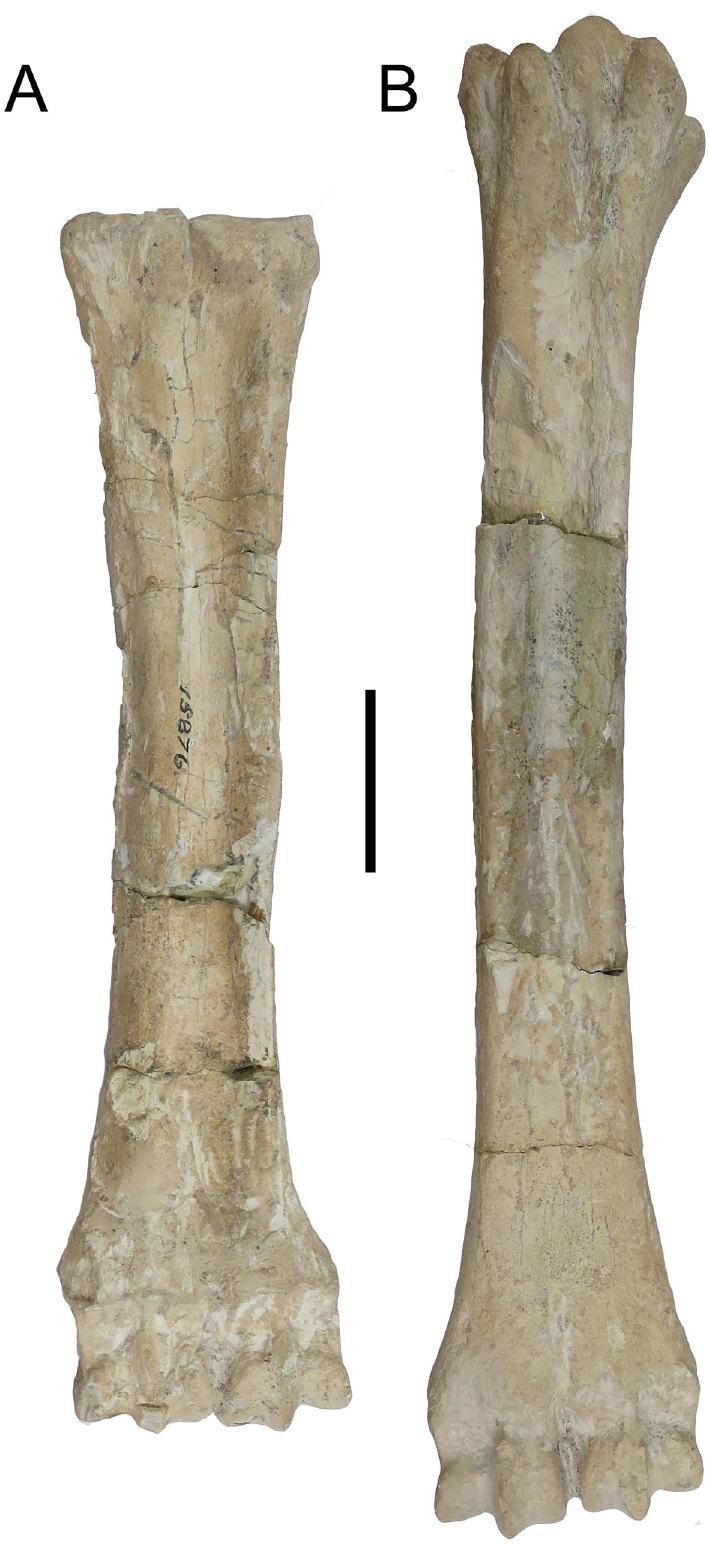
Fig 17. Samotherium boissieri metapodials from Samos. (A) Right metacarpal AMNH 15867. (B) Left metatarsal AMNH 15867. Scale 50mm. https://doi.org/10.1371/journal.pone.0211797.g017 PLOS ONE | https://doi.org/10.1371/journal.pone.0211797 February 12,